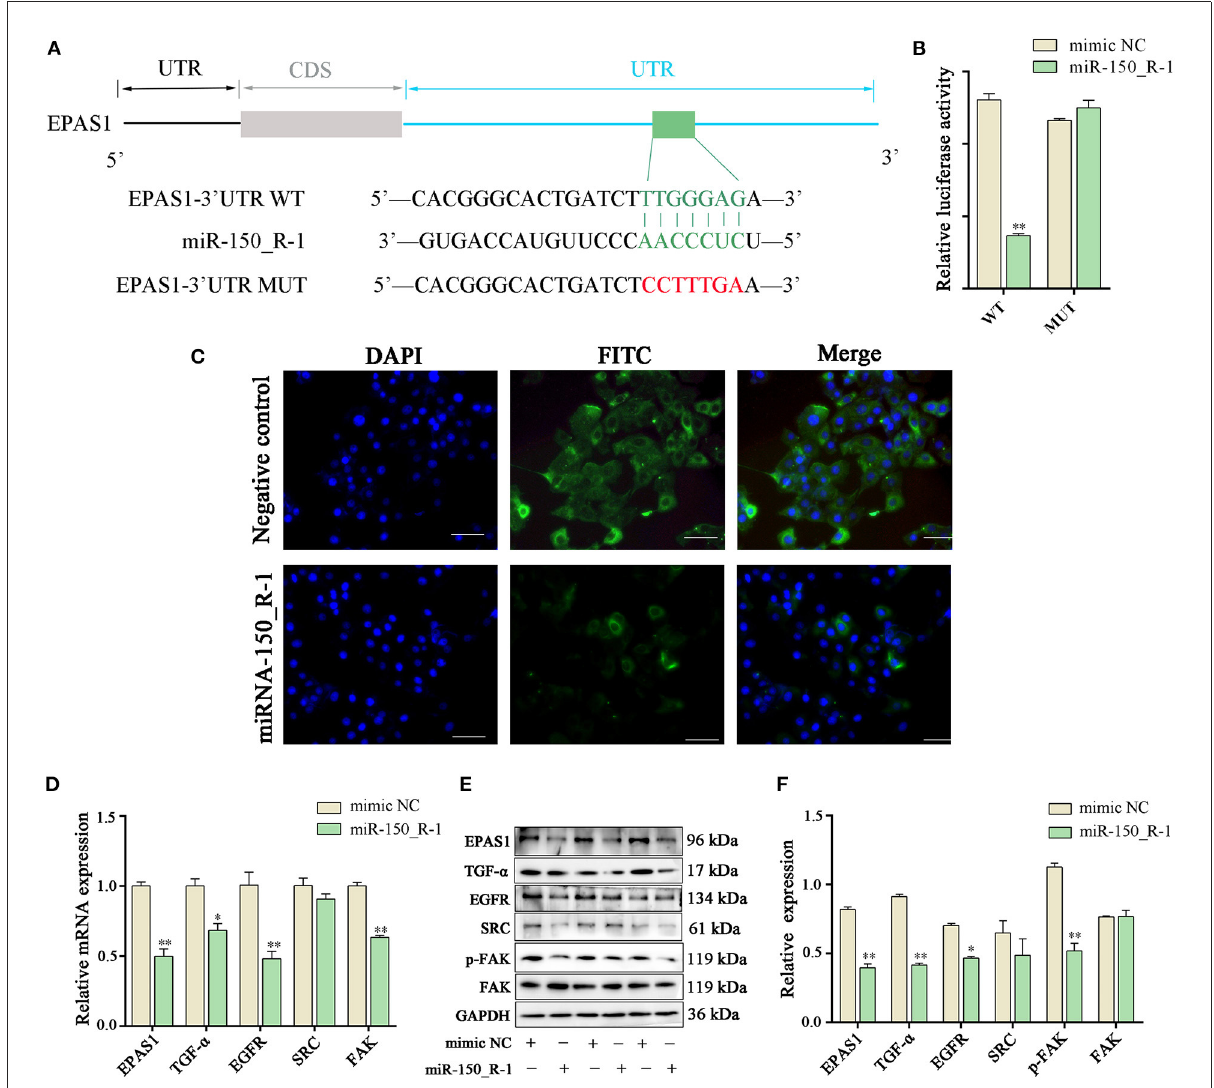
FIGURE6 EPAS1 is regulated by miRNA-150_R-1. (A) Binding site of EPAS1 and miR-150_R-1. (B) Luciferase activity in BEND cells after co-transfection with miR-150_R-1 mimic (50nM) or mimic NC (50nM) and pmirGLO-EPAS1 3 ′ -UTR-WT (400 ng) or pmirGLO-EPAS1 3 ′ -UTR-MUT (400 ng). (C) Immunofluorescence analysis of EPAS1 in NC mimic and miR-150_R-1 mimic groups. The nuclei were stained with DAPI (blue). Magnification: 100 × . (D) Expression levels of mRNAs in HIF-1/ErbB pathways analyzed using PCR. (E) Strip chart of proteins in the HIF-1/ErbB pathway by western blotting. (F) Grayscale value of the western blotting strip map. Data represent the mean ± SEM. * p < 0.05, ** p < 0.01. UTR, untranslated region; CDS, coding sequence; MUT, mutant type; WT,